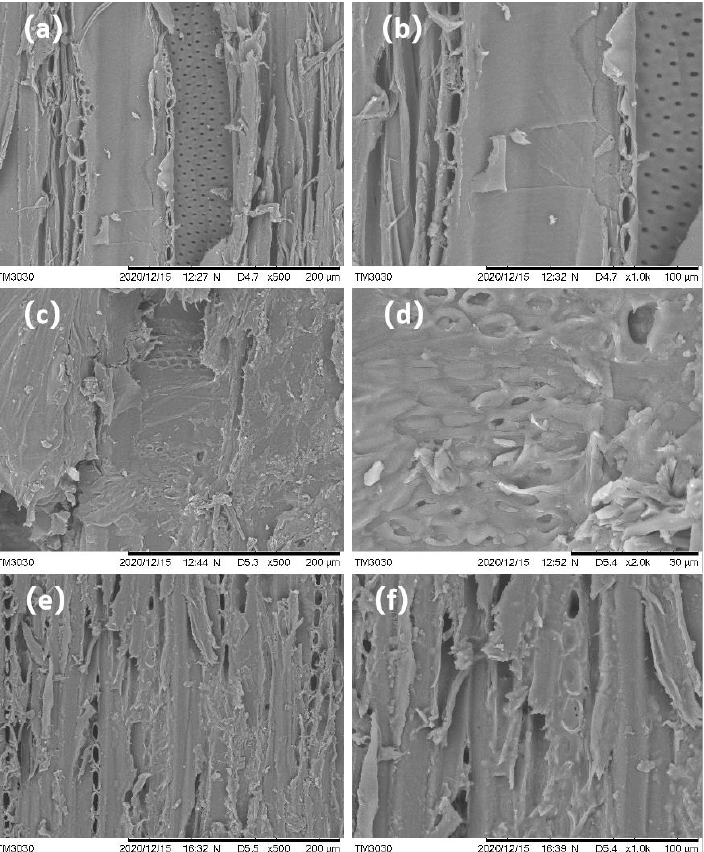
Figure 1. SEM images of wood veneers unmodified and modified at tangential section. ( a , b ) An unmodified wood with different magnifications. ( c , d ) A 10% GP-impregnated wood-blocked pits with different magnifications. ( e , f ) A 10% GP-impregnated wood-blocked wood ray cells with different